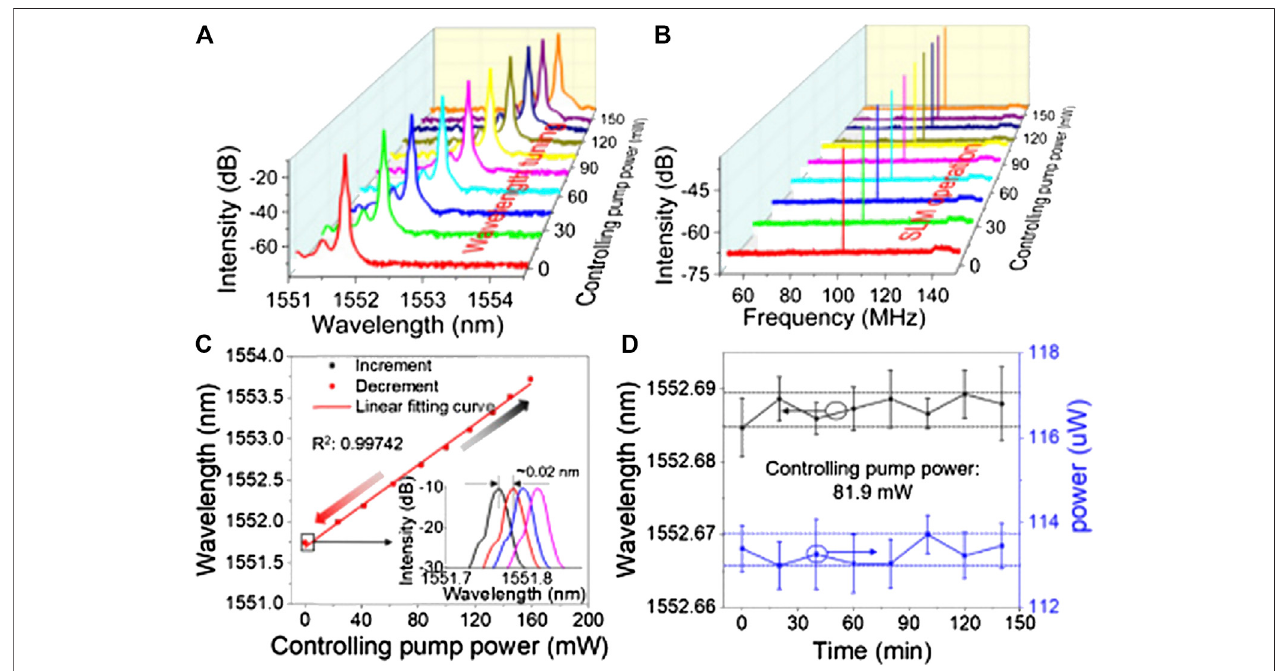
FIGURE13|(A) Outputspectraoftheultra-narrowlinewidthlaserwiththeincrementofthepump3; (B) color-correspondedRFspectraduringthetuningprocess; (C) peak wavelengthswithchanged powers ofpump three and thelinear fi ttingcurve; (D) long-termstability test ofthewavelengthand outputpower witha fi xed power of pump 3. Copyright 2018, Optical Society of America.